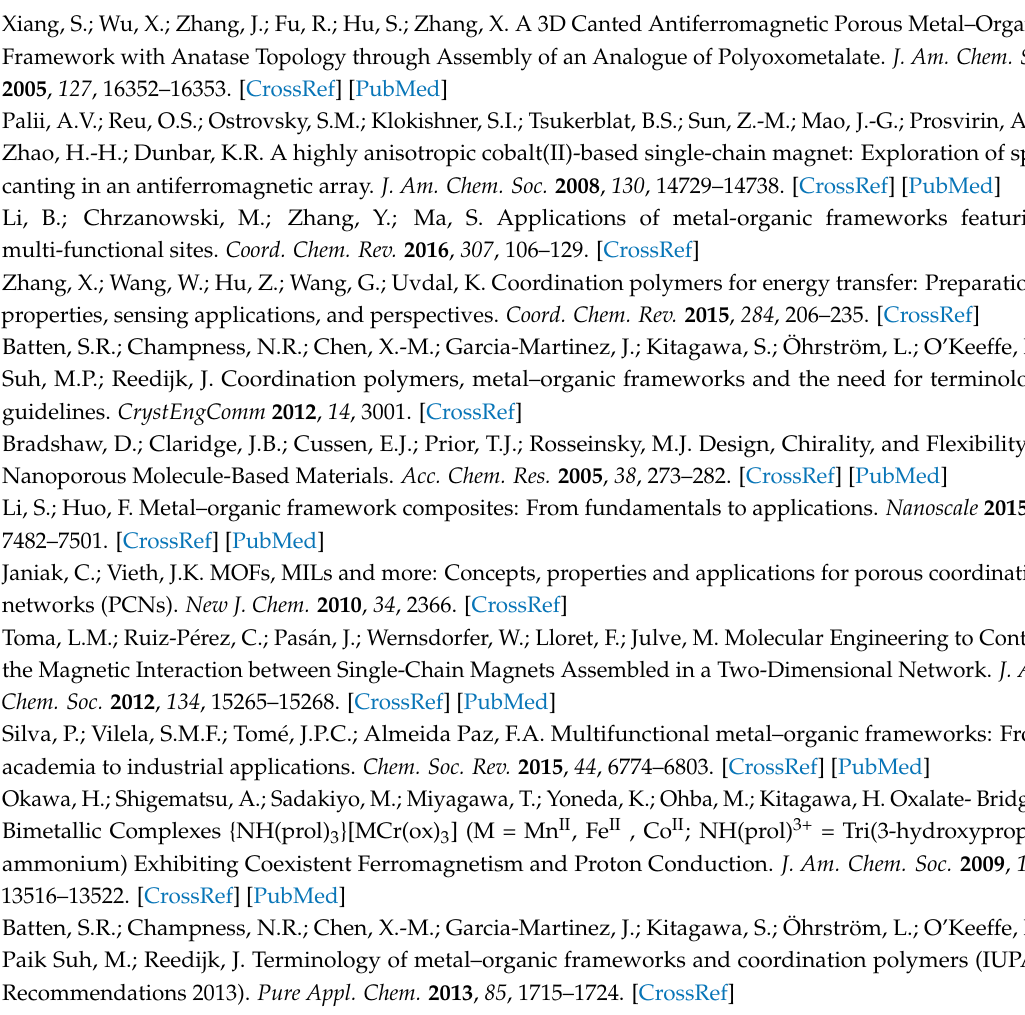
Figure S1: Simulated PXRD pattern (blue) and experimental PXRD pattern (red) of Compounds (a) 1 and (b) 2 . Figure S2: Thermogravimetric (TG) analysis diagrams of Compounds 1 (red line) and 2 (blue line). Figure S3: Plot of χ M − 1 ( ) vs. T of Compound 1. The solid line represents the best fit χ M − 1 above 100 K with a Curie–Weiss law. Figure S4: Plot of χ M ( ) vs. T of Compound 1 . Figure S5: ZFC/FC magnetizations of Compound 1 at a field of 10 (cid:35) Oe. Figure S6: Plot of χ M − 1 ( ) vs. T of Compound 2 . The solid line represents the best fit χ M − 1 above 100 K (cid:35) with a Curie–Weiss law. Figure S7: In-phase ( χ (cid:48) ) and out-of-phase ( χ (cid:48)(cid:48) ) of the ac magnetic susceptibilities in a zero (cid:35) applied dc field and a 3.5 G ac field at the indicated frequencies for Compound 2 . Figure S8: χ M (cid:48) vs. H plots for field dependence of the ac magnetic susceptibilities in a zero applied dc field and in a 3.5 Oe ac field and 100 Hz at 2.0 K for 2 . Figure S9: EPR spectra of (a) Compound 1 and (b) Compound 2